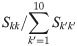
Decomposition of free swimming zebrafish larval backbone shapes into orthonormal basis.(A) Still images of a swim bout from a representative movie of free swimming zebrafish larva, recorded at 500 fps. (B) Spline fit of fish backbone (cyan). Tangent vectors (black arrow) at 10 evenly spaced segments along the backbone from head (s
0 = 0) to tail (s
9 = 9) point along a direction θ(s
j). (C) Swim bout from A parameterized by Δθ(s
j,t
i) = θ(s
j,t
i)–θ(0,t
i). (D) Singular value decomposition of Δθ into eigenshapes V
k(s
j) (j = 1, 2… 9), the first three of which are plotted (red, blue, and green, respectively). The light colors correspond to eigenshapes determined from analyzing individual fish from a population, and dark colors are the collective eigenshapes from analyzing the entire population at once. (E) Bar plot of % weights (Skk/∑k′=110Sk′k′, where S
kk are the singular values) of each eigenfunction V
k(s
j). The right axis in cyan shows the cumulative contribution of each eigenshape. The first three eigenshapes contribute 96% of the total variance in Δθ.